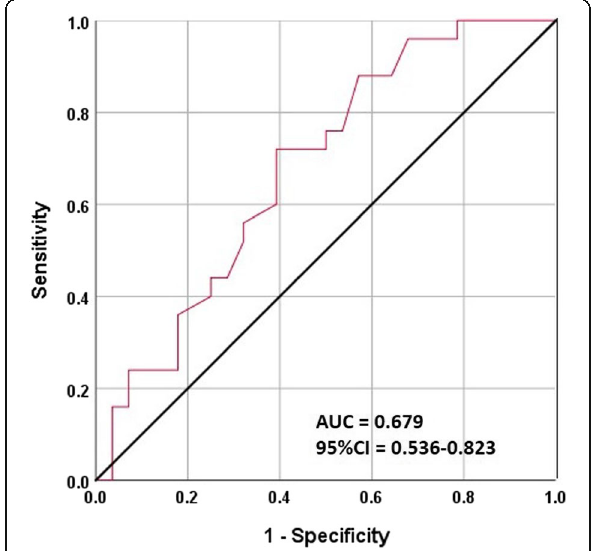
Fig. 2 Receiver operating characteristic curve for MMP-2 in the context of discrimination between controlled epileptics and controls. MMP-2, matrix